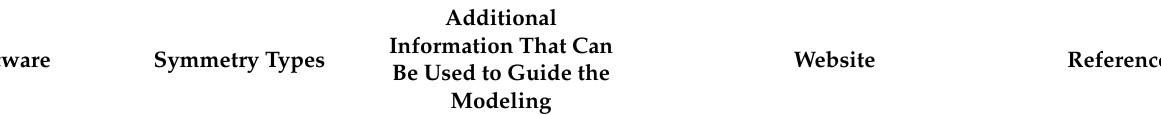
Table 1. A summary of available software, designed for the modeling of symmetric homo-oligomeric protein complexes. When a webserver is available, only the number of subunits and the additional information, used to guide the modeling, that can be inputted into the webserver are